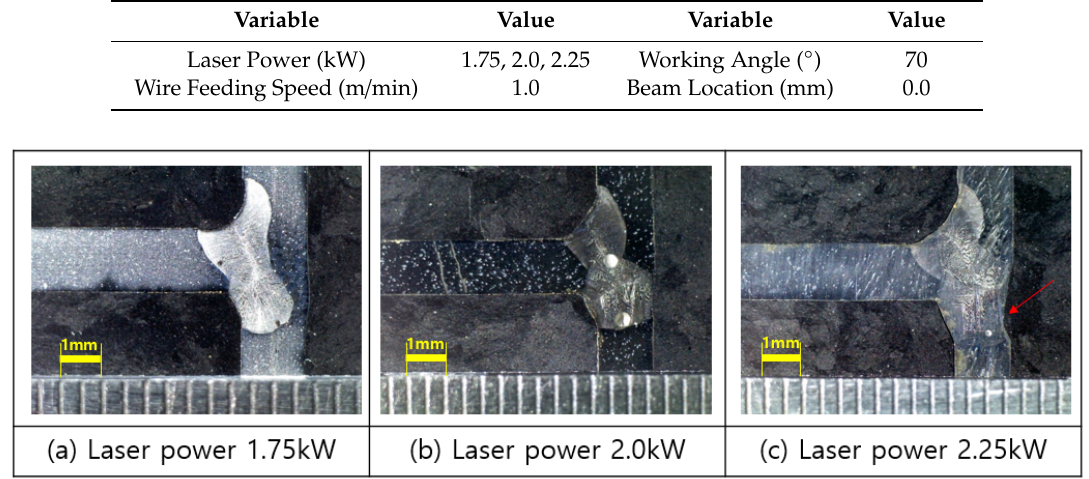
Figure 7. Di ff erences among laser powers. Figure 7. Differences among laser powers.